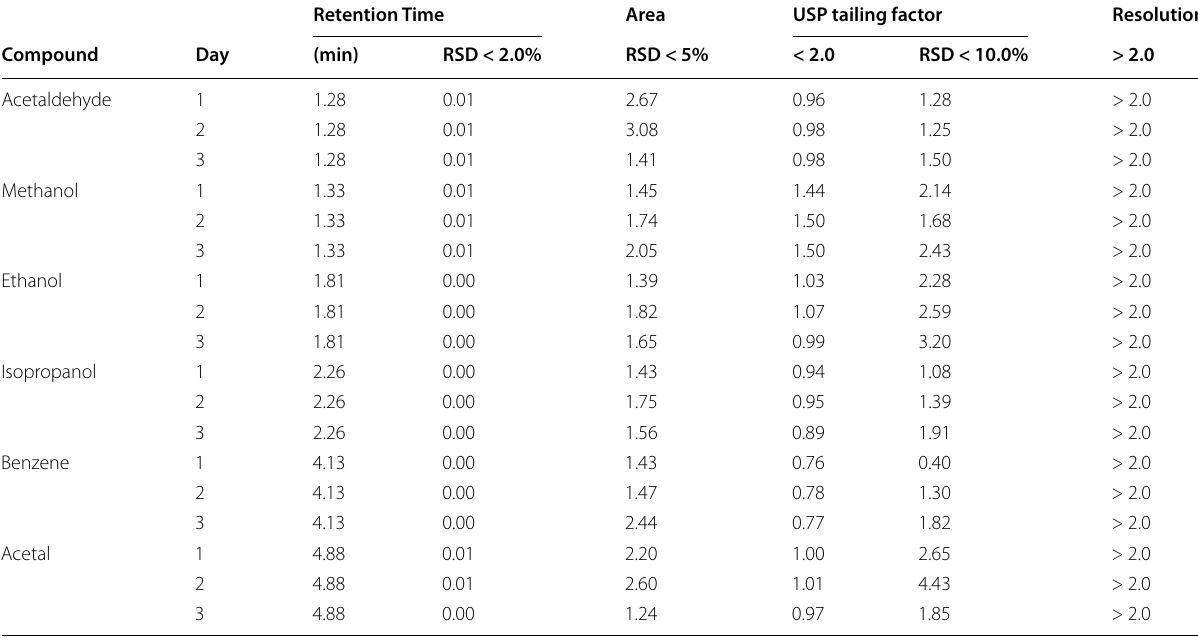
Table 2 System suitability testing specifications and results Retention Time Area USP tailing factor